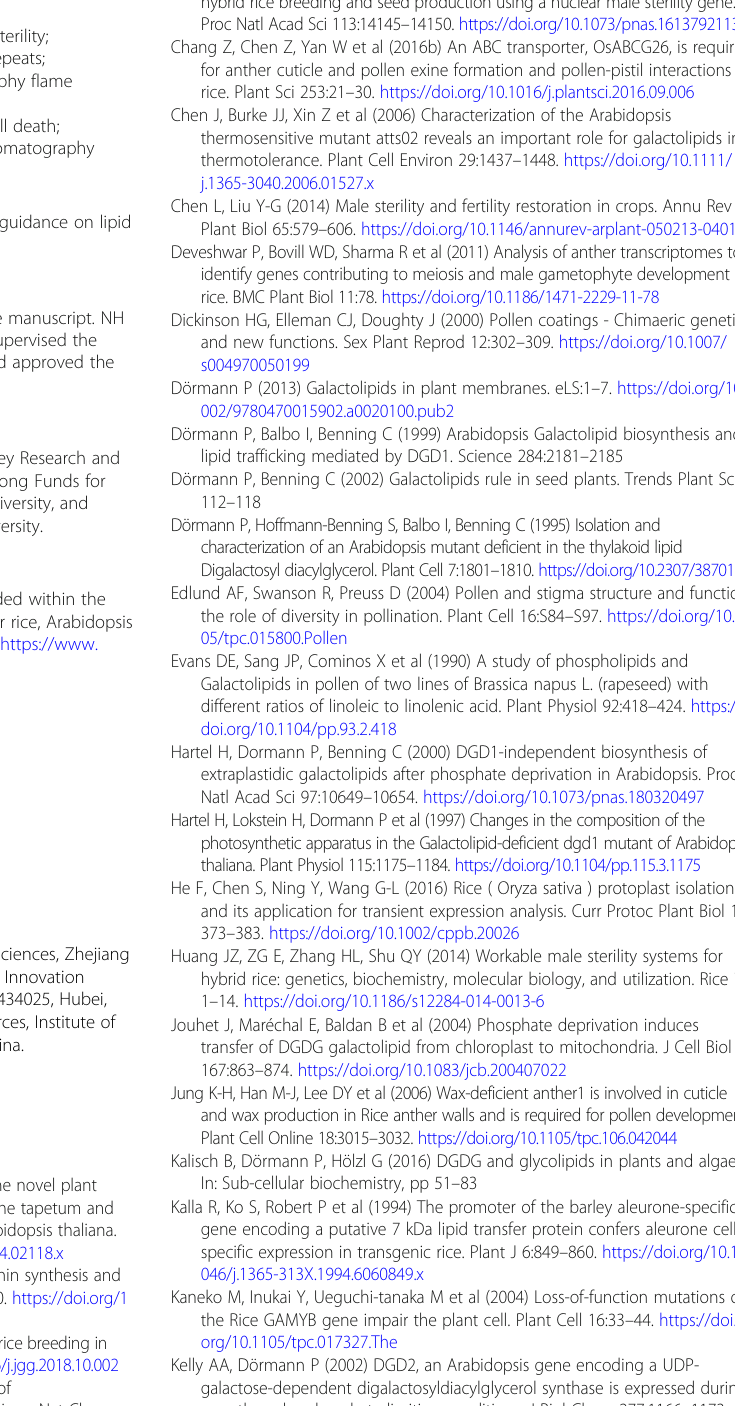
hybrid seed production by crossing with WT-B. Blue shaded box represents transgenic lines. + and – represents wild-type and mutated OsDGD2 β , respectively. ⨂ represents self-pollination. Detailed information is provided in the article (Discussion 3.3). (PDF 37 kb) Additional file 9: Table S9. List of oligos and primers (XLS 49 kb) Abbreviations Cas9: CRISPR associated protein 9; CMS: Cytoplasmic male sterility; CRISPR: Clustered regularly interspaced short palindromic